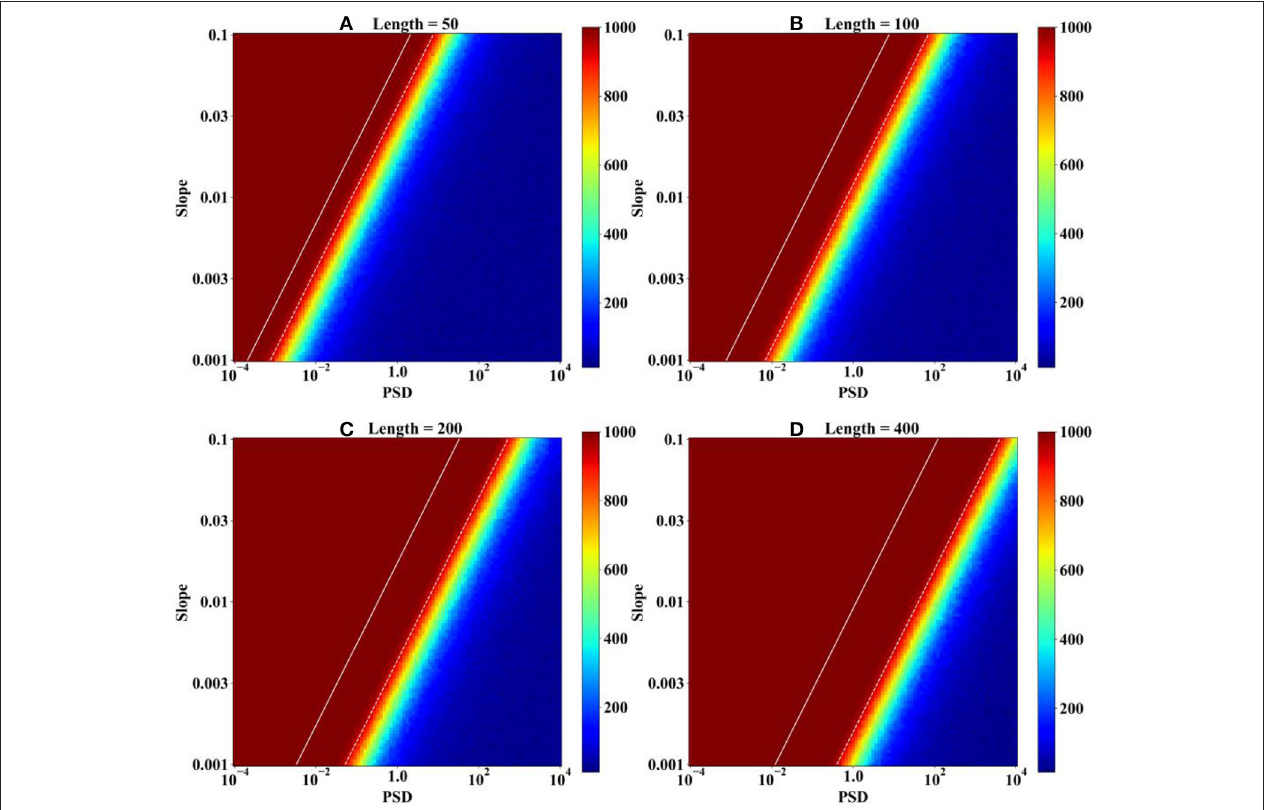
FIGURE 3 | Heat map of the rejection number under different combinations of PSD and slope. (A) Sample lengths lengths 200; and (D) sample lengths =